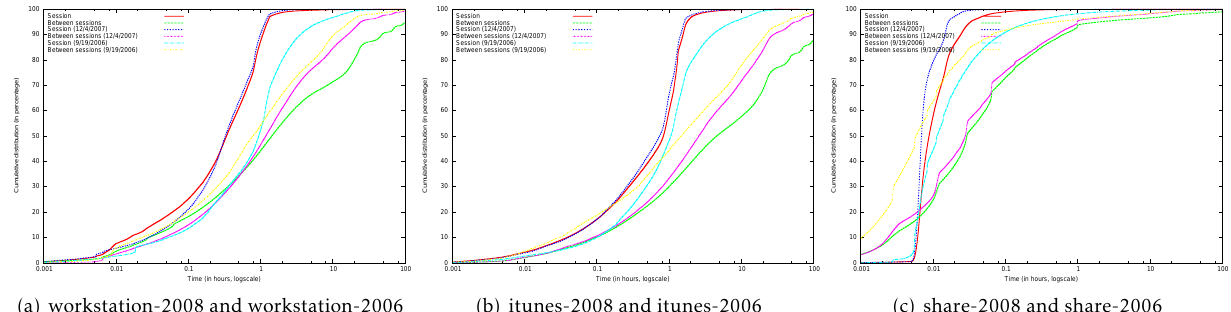
Figure 3. Online availability behavior of campus users